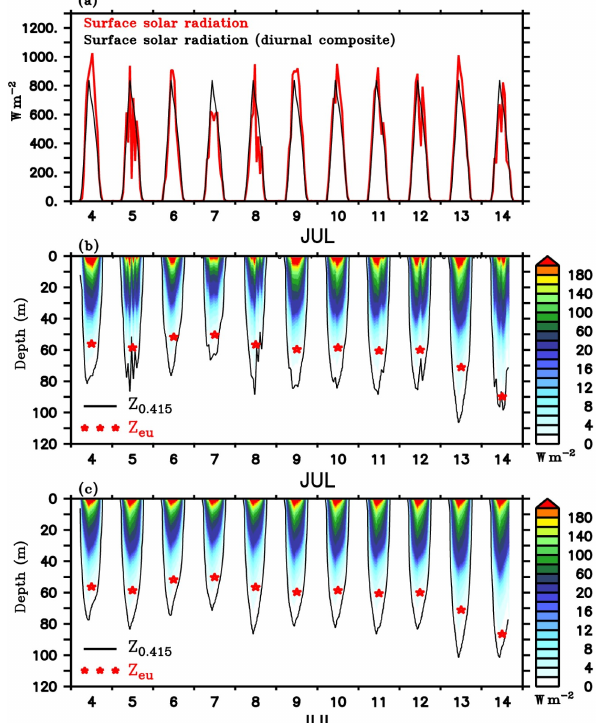
Figure 11. (a) Surface solar radiation measured by the shipboard AWS at TSE from 4 to 14 July (red), and the corresponding di- urnal composite (black) calculated for the same period. Penetrative shortwave radiation is (Wm − 2 ) calculated following Morel and An- toine (1994) and Manizza et al. (2005) scheme using (b) observed and (c) diurnal composite of radiation. Chlorophyll from SG620 is used for the calculations. Photosynthetically active radiation (PAR; Em − 2 s − 1 ) was estimated from the calculated penetrative radiation in the visible range, following Morel and Smith (1974). The red stars in (b) and (c) represent daily averaged depth of euphotic zone ( Z eu , m) which is taken as the depth at which light reduces to 1% of the surface PAR value. The black contours in (b) and (c) repre- sent the depth of threshold isolume ( Z 0 . 415 , m) taken as the depth at which PAR is 0.415Em − 2 s − 1